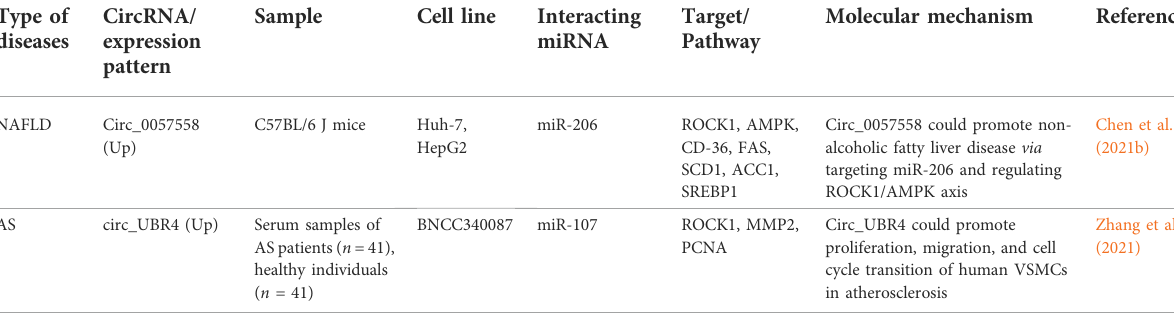
TABLE 3 ROCK1-interacting circRNAs in non-malignant conditions (NAFTD: Non-alcoholic fatty liver disease, AS: atherosclerosis). Type of diseases